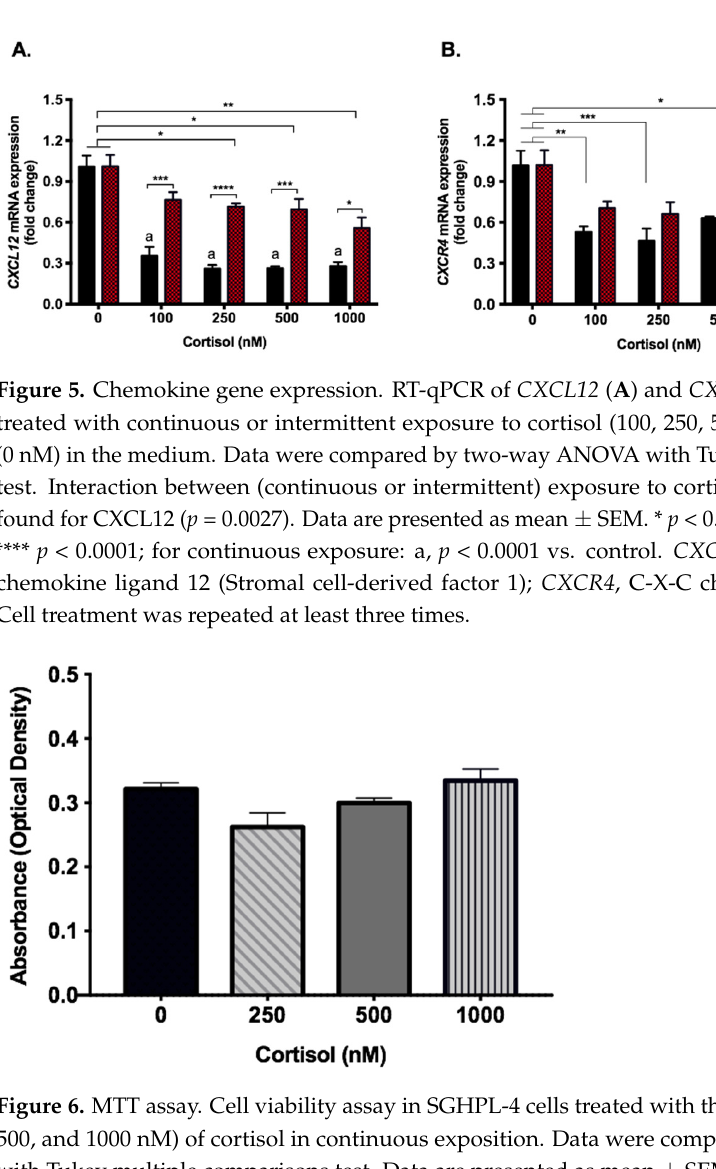
Figure 6. MTT assay. Cell viability assay in SGHPL-4 cells treated with the three highest doses (250, 500, and 1000 nM) of cortisol in continuous exposition. Data were compared by one-way ANOVA with Tukey multiple comparisons test. Data are presented as mean ± SEM.